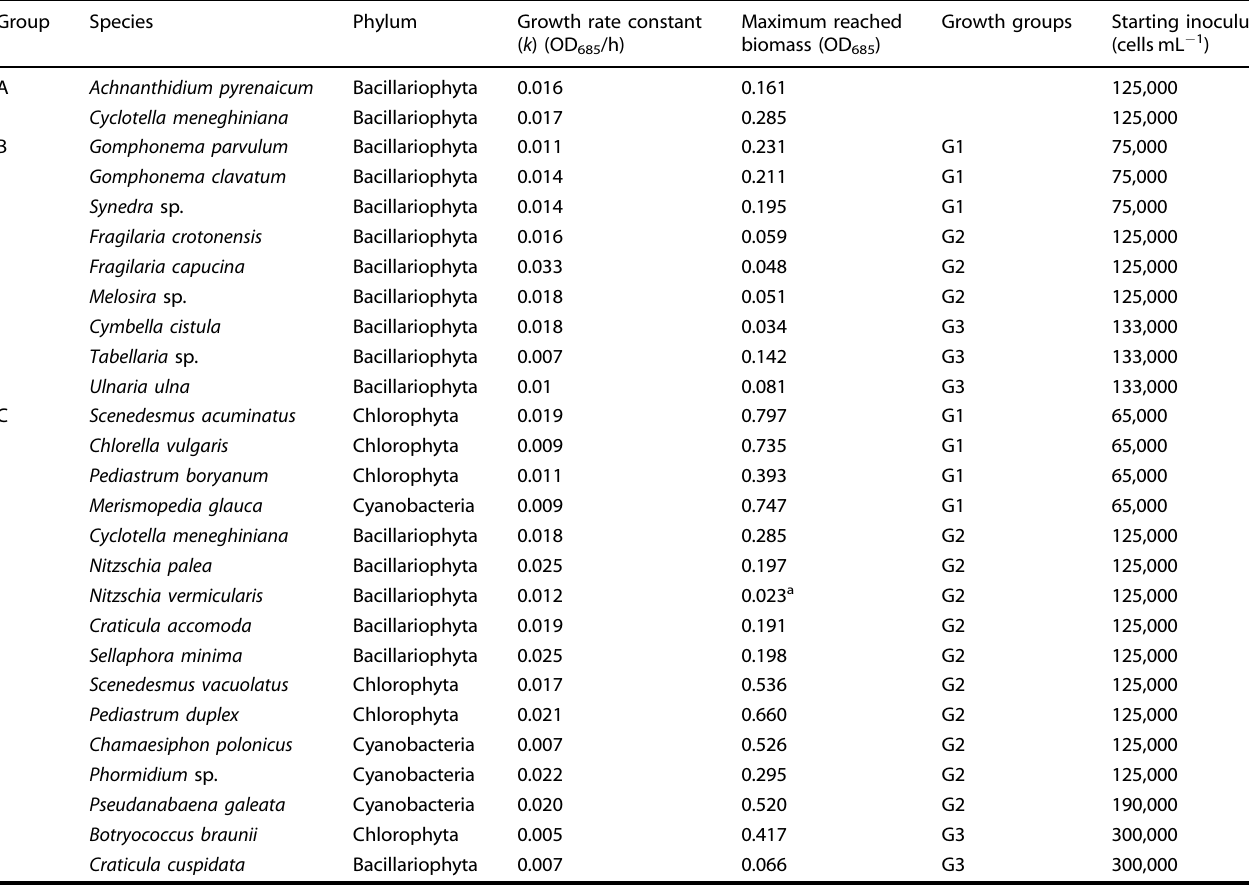
Table 1. List of the 26 selected phototrophic species used to establish the